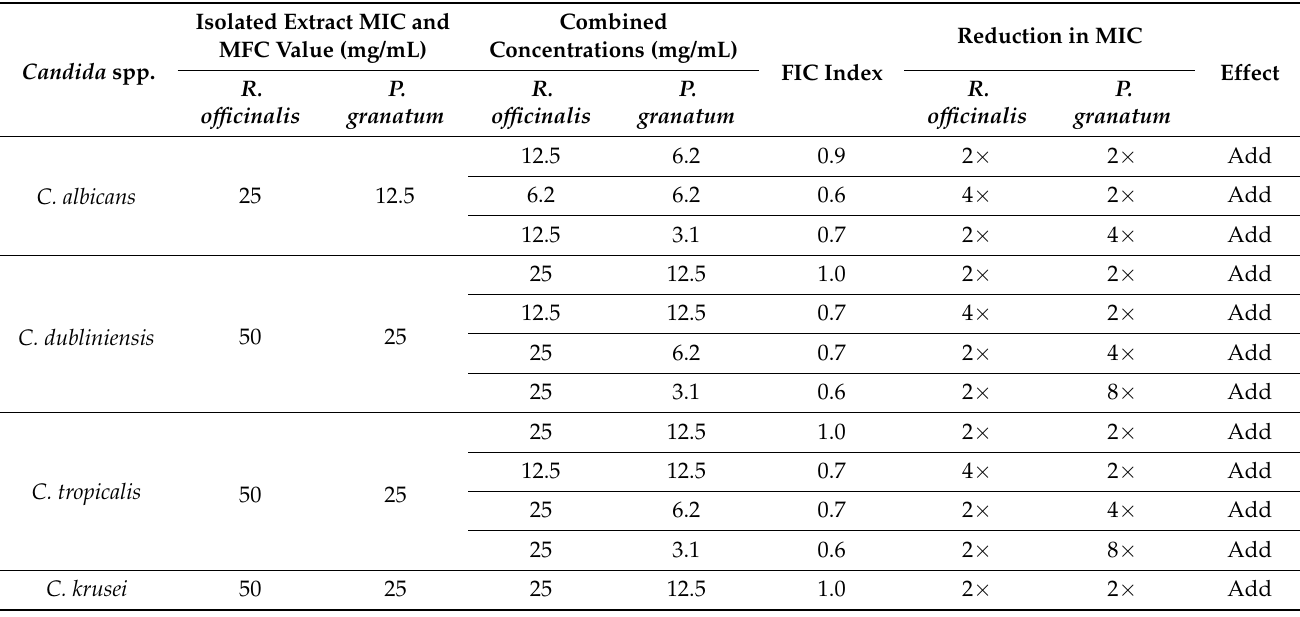
Table 6. Minimum inhibitory concentration (MIC) and minimum fungicidal concentration (MFC) values in mg/mL, in addition to the combined effect of R. officinalis and P. granatum glycolic extracts, against Candida